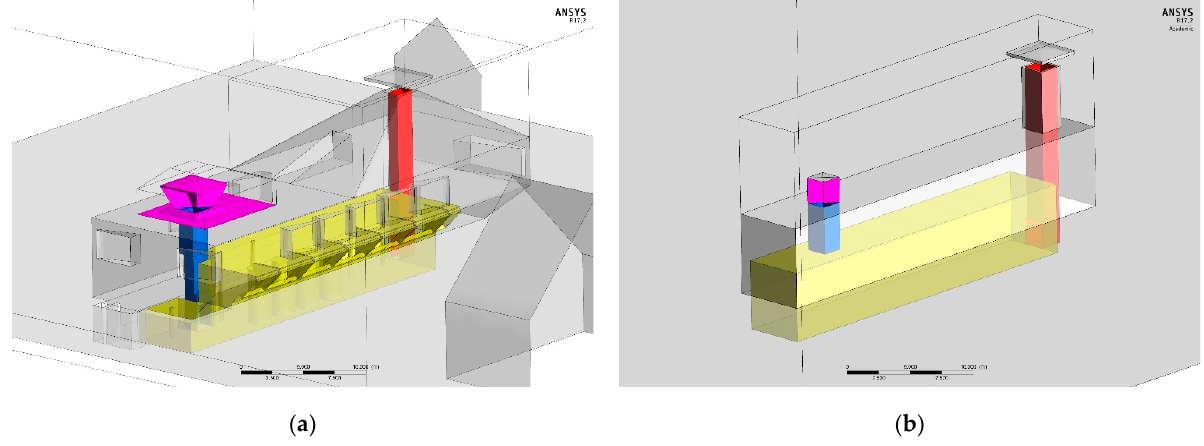
Figure 5. ( a ) Geometry of the original building with validated CFD simulations [31]; ( b ) simplified geometry for generalized results on the wind catcher topology—gray shows the simplified environ- ment, blue the inlet, red the outlet tower, yellow the interior of the cellar, and purple the investigated wind catcher geometry.